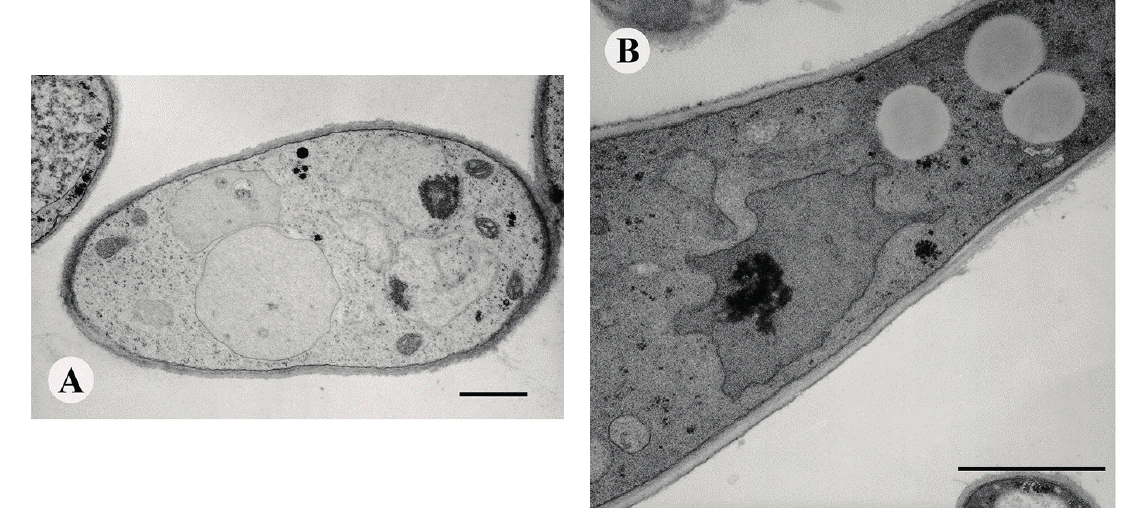
Figure 3. ( A ) Untreated control hypha of M. gypseum observed by TEM. The nucleus and the cell wall are normally structured; ( B ) TEM of M. gypseum treated with 100 μ g/mL α -bisabolol. The nucleus shows deep invaginations. Bar, 1 μ m.